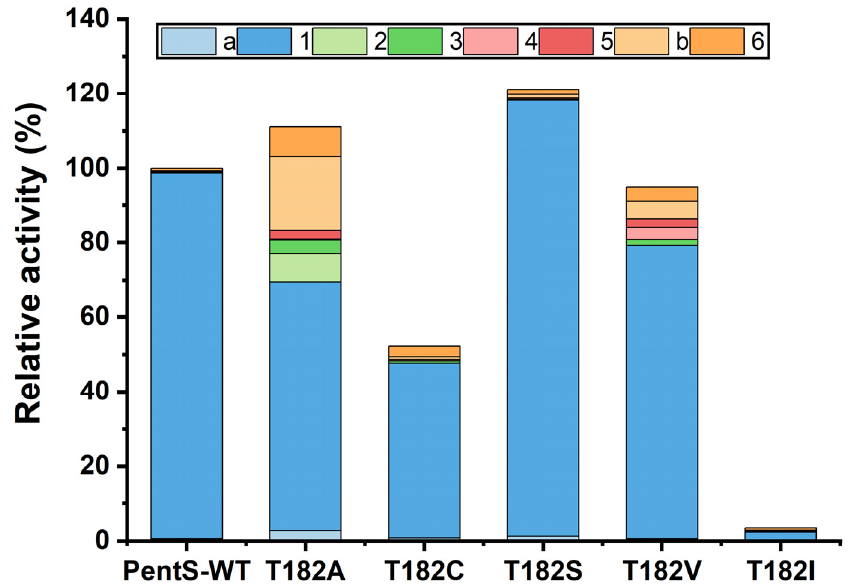
Figure 2. Relative activity and product distribution of wild type and variants of PentS. The relative activity was determined by the peak area of sesquiterpene. The relative activity of wild-type PentS (total sesquiterpene production) is 100%. a and b indicate unidentified hydrocarbons with m/z 204. 1 – 6 were tentatively predicted as pentalenene, sativene, longifolene-V4, β -chamigrene, thujopsene-I3, and β -elemene, respectively.